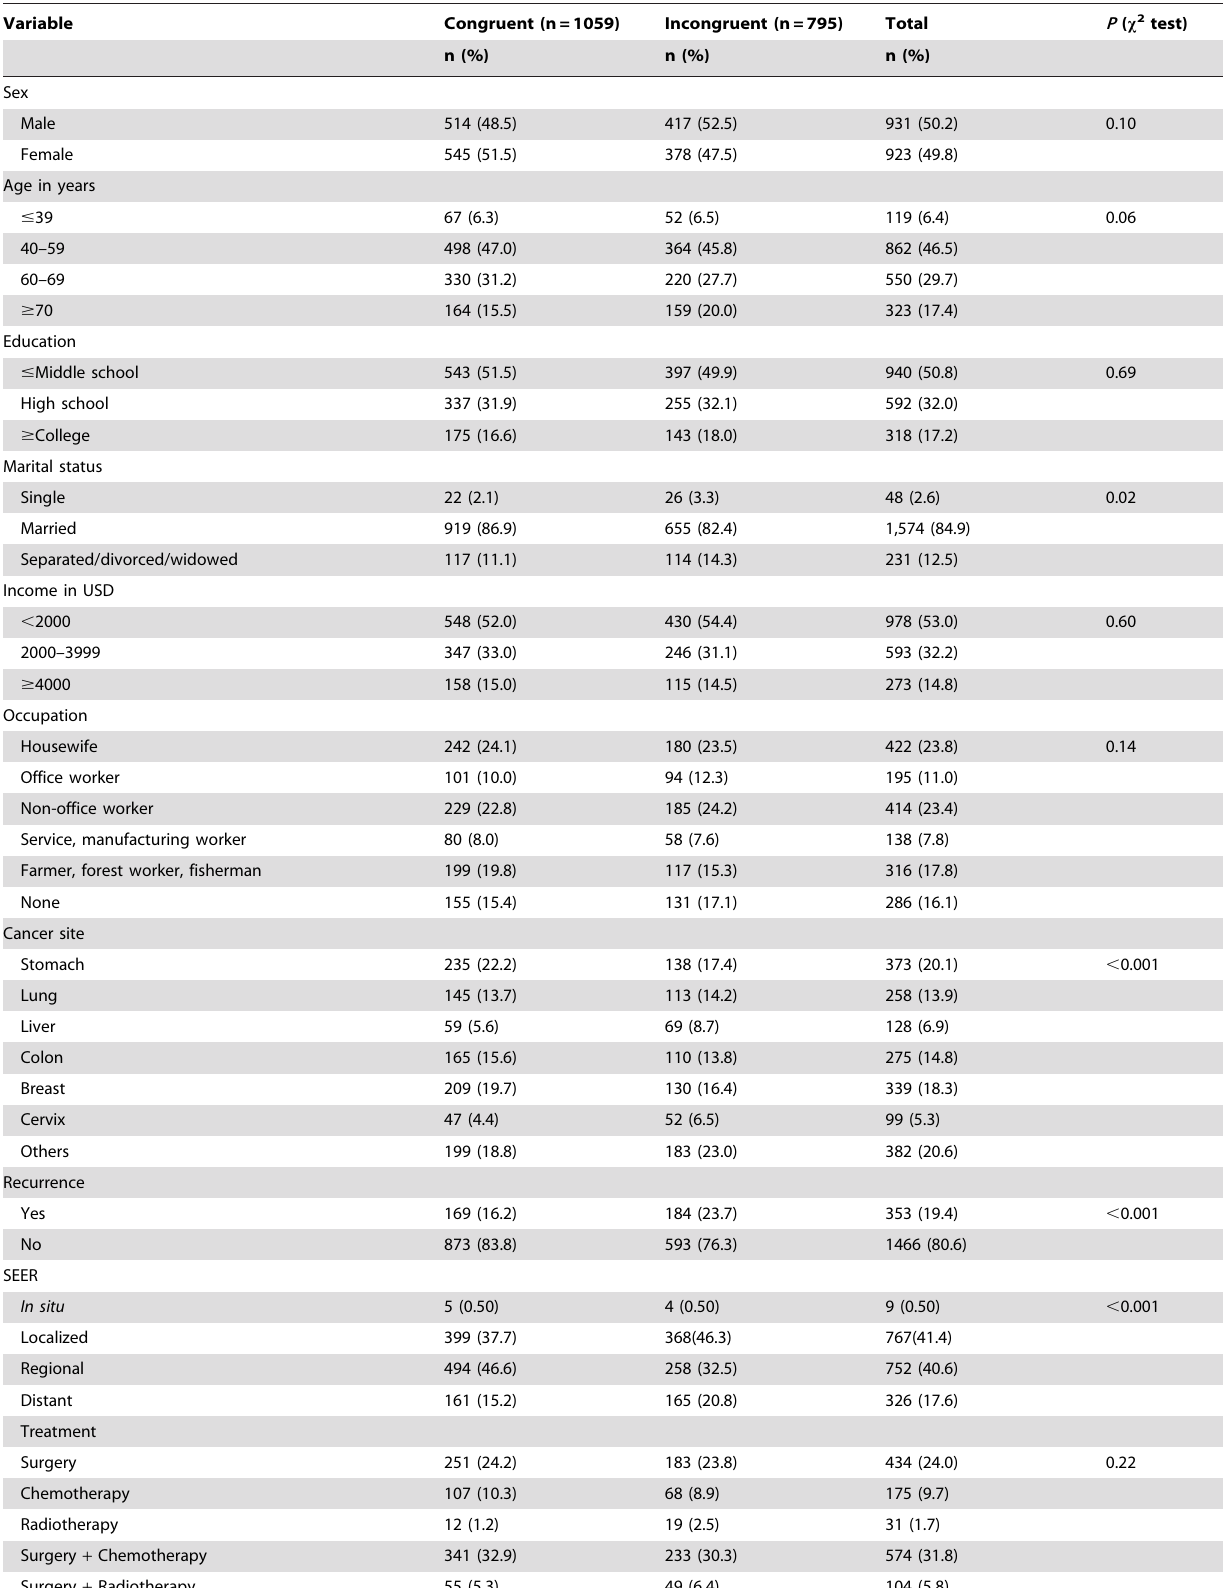
Table 1. Characteristics of the congruent and incongruent